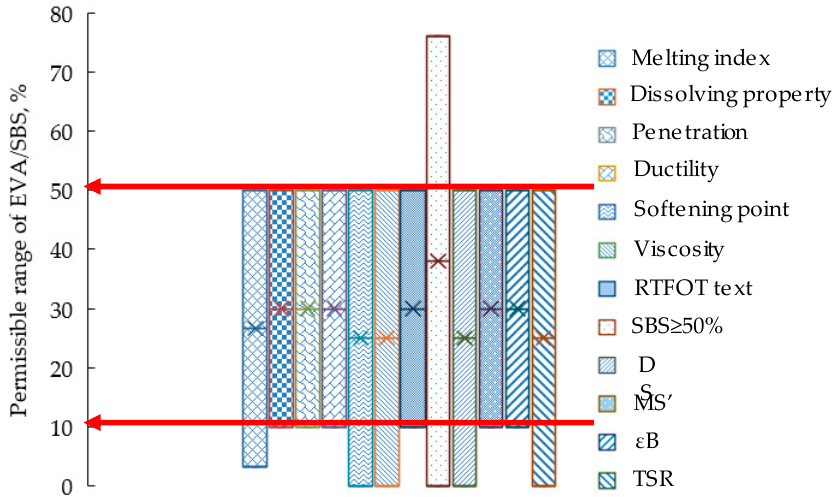
Figure 11. The permissible proportion range of EVA when naphthenic oil/SBS =16%.